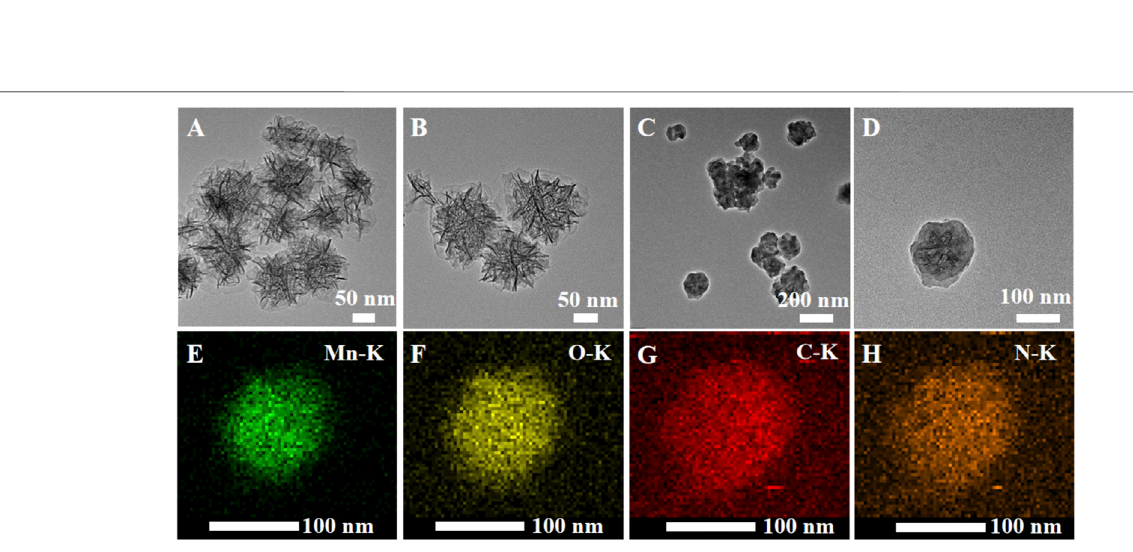
FIGURE 2 | TEM images of (A,B) MONs (C,D) MONs@PDA (E – H) Elemental mapping of Mn, O, C,